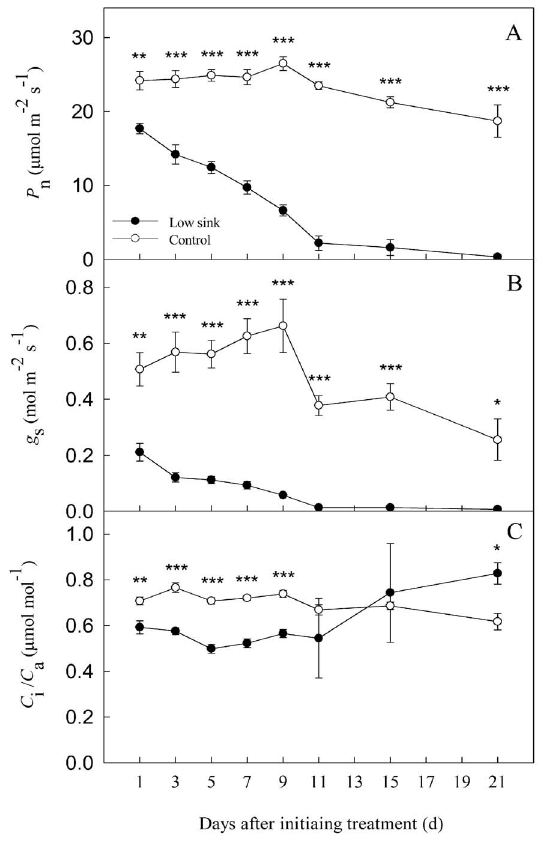
Figure 2. The response of gas exchange parameters including net photosynthesis rate ( P n ), stomatal conductance ( g s ) and internal-to-ambient CO 2 concentration ratio ( C i / C a ) in bean source leaves to the treatment of low sink demand at 1300 h from the 1 st to 21 st day after removing the sink of roots and pods. Each value represents the mean of five replicates, and error bars represent 6 S.E. The asterisks *, ** and *** indicate significant difference at P , 0.05, 0.01 and 0.001 between the control and treatment, respectively.